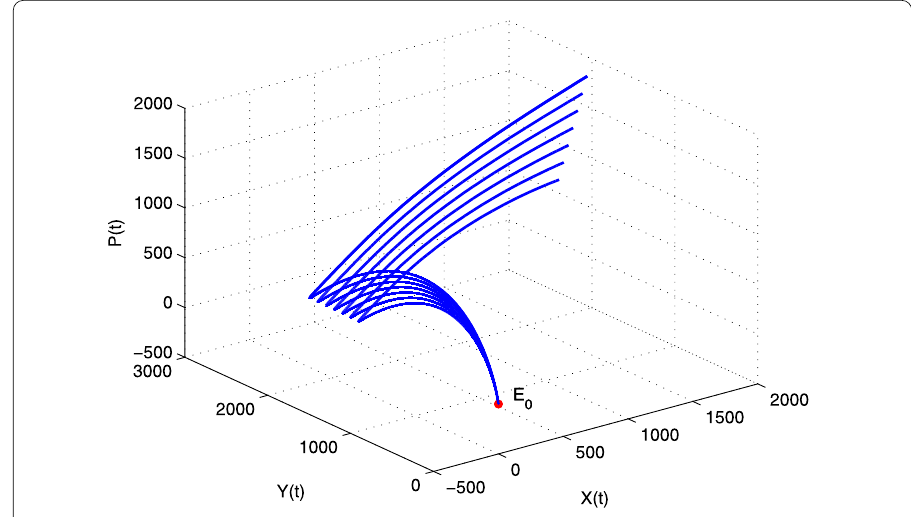
Figure 2 The boundary equilibrium E 0 is asymptotically stable with the parameters a 1 = 1, a 2 = 1, b